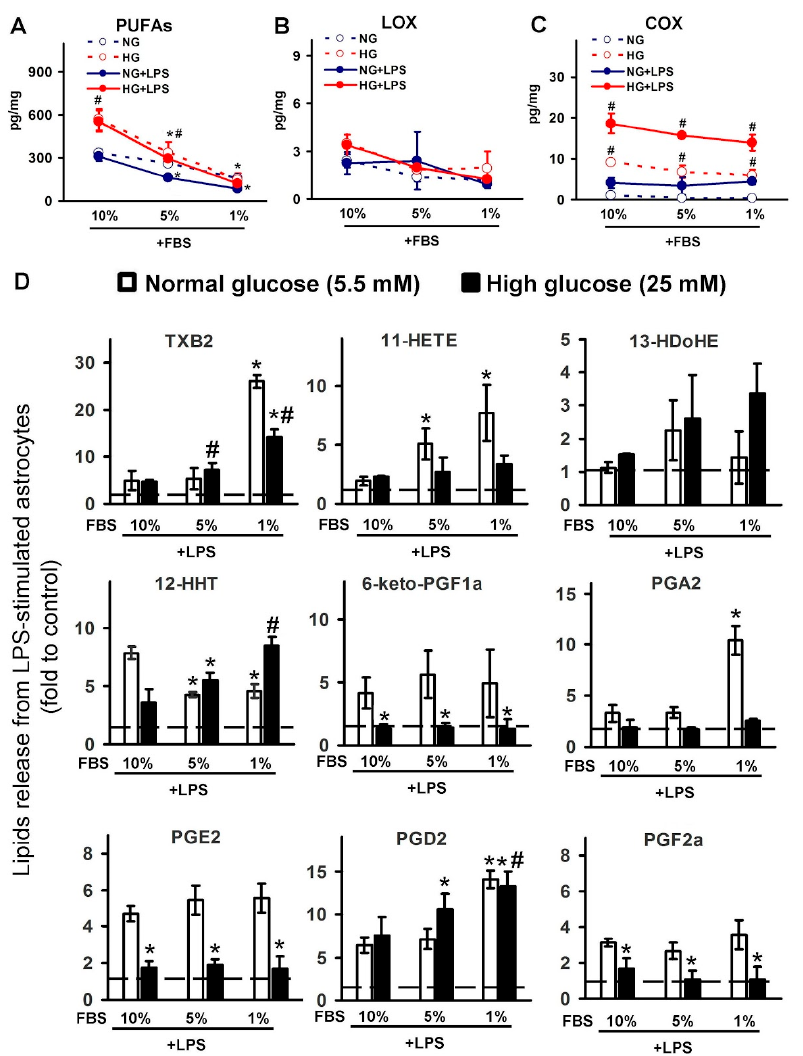
Figure 3. Dependence of detected oxylipins on serum concentrations in the culture medium in LPS-stimulated cells, cultivated in normal (5.5 mM) or high (25 mM) glucose medium. Primary rat astrocytes were cultivated in normal (5.5 mM) or high (25 mM) glucose medium with FBS concen- tration at 10%, 5%, and 1%, and then stimulated with lipopolysaccharide (LPS, 100 ng/mL) for 4 h. Concentrations of oxylipins in supernatants were measured using ultra-performance liquid chro- matography-tandem mass spectrometry (UPLC-MS/MS). The values represent a mean ± SEM from three independent experiments. ( A ) the concentrations of the detected PUFAs were summed up; ( B ) the concentrations of the detected LOX-derived metabolites were summed up; ( C ) the concen- trations of the detected COX-derived metabolites were summed up; ( D ) the results expressed as fold change, relative to the control, with the corresponding percentage of serum. * p < 0.05, com- pared with the LPS-stimulated cells under normal glucose conditions, with 10% FBS; # p < 0.05, compared with the LPS-stimulated cells under high glucose conditions, with 10% FBS. Abbrevia- tions: PUFAs - polyunsaturated fatty acids, LOX - lipoxygenase, COX - cyclooxygenase, TXB2 - thromboxane B2, HETE - hydroxyeicosatetraenoic acids, HDoHE - hydroxydocosahexaenoic acids, HHT - hydroxyheptadecatrenoic acid, 6-keto-PGF1a - 6-keto-prostaglandin F1a, PGA2 - prostaglan- din A2, PGE2 - prostaglandin E2, PGD2 - prostaglandin D2, PGF2a - Prostaglandin F2a.